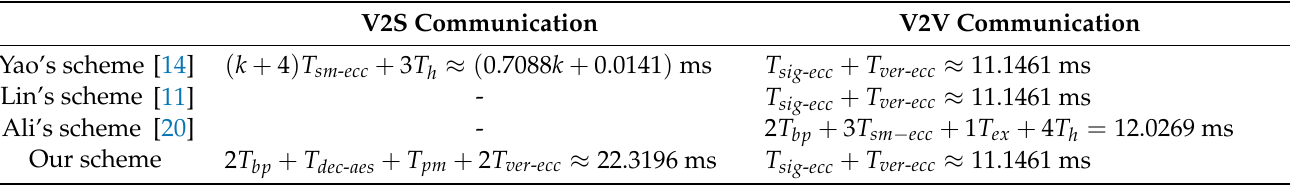
Table 5. Comparison of computing cost.